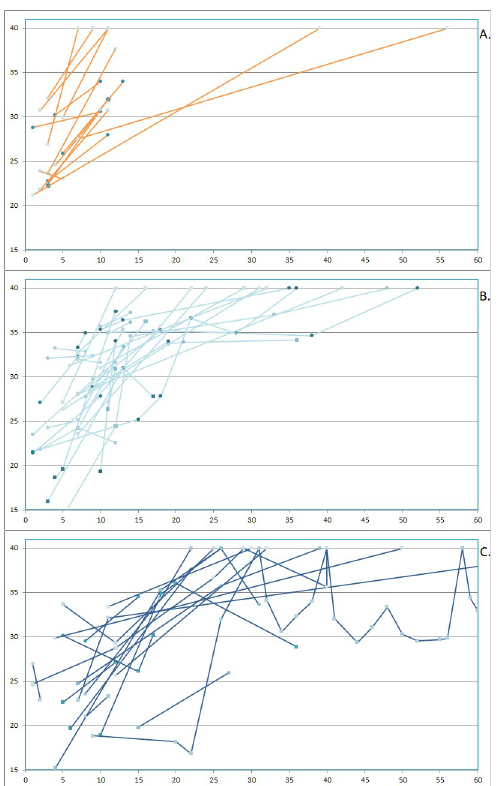
Fig 4. SARS-CoV-2 PCR C q -values over time in 17 non-hospitalised patients (displayed in orange) ( a ), 33 hospitalised patients with moderate COVID-19 disease (displayed in light blue) ( b ) and 18 hospitalised patients with severe disease (displayed in dark blue) ( c ). The y-axis displays C q -value and the x-axis displays days from symptom onset. Circle = naso-and/or-oropharyngeal swabs, squares = sputum samples.